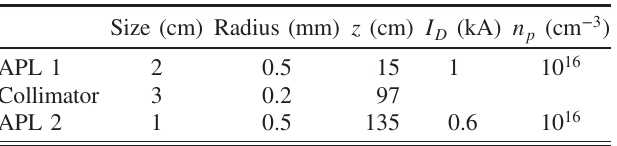
TABLE II. Optimized parameters (size, radius, and position) for the APLs and collimator used in the proposed extraction system. The position of each element (along z ) is relative to the exit of the PWFA module. For the APLs, the current discharge ( I ) and plasma density ( n ) are also D p